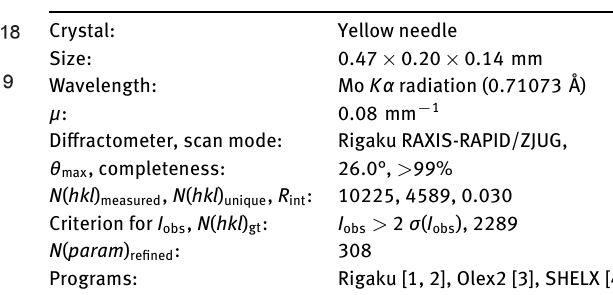
Table 1: Data collection and handling.